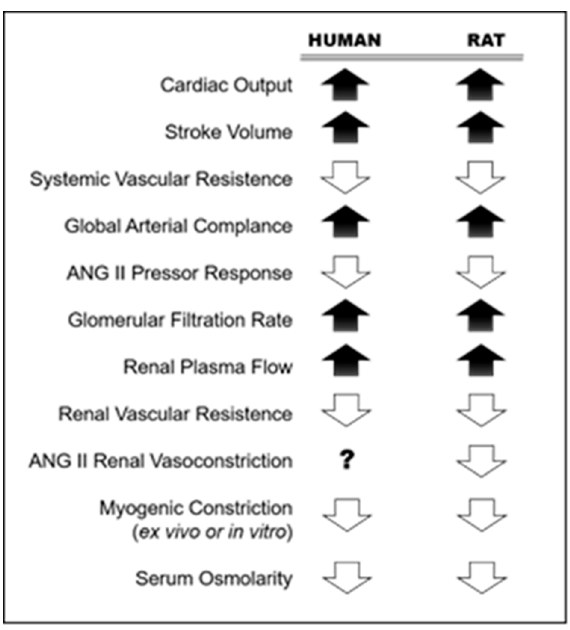
Figure 2. Renal and systemic vasodilation during pregnancy in human and rat. Adapted from: Conrad, 2011 [198].